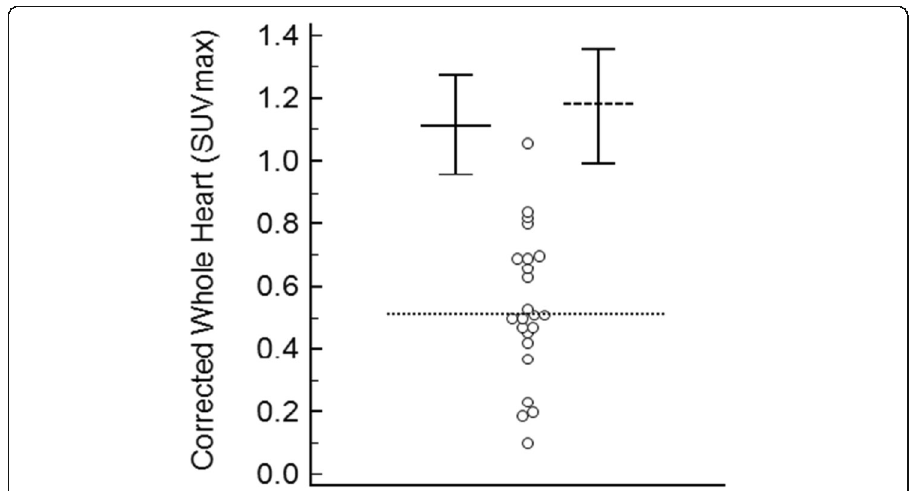
Fig. 7 Distribution of corrected whole heart SUVmax for individuals without ATTR cardiac amyloid with the upper limits of 99% reference levels and their associated 90% confidence intervals marked. The dashed horizontal line represents the reference level determined by the robust method, the solid line the reference level determined assuming a normal distribution, and the dotted line is the